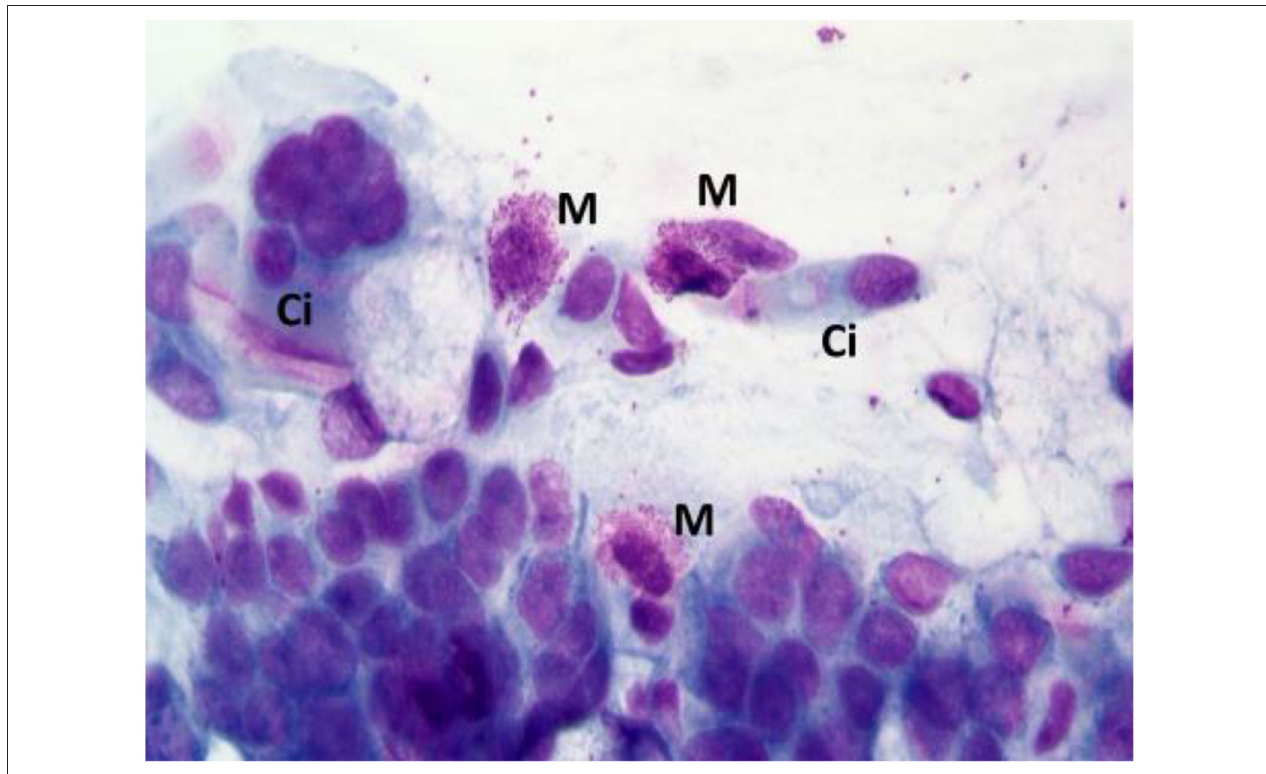
FIGURE 2 | Nasal cytology of NARMA. M, mast cell; D, Degranulation; Ci, ciliated cell. MGG staining. Magnification